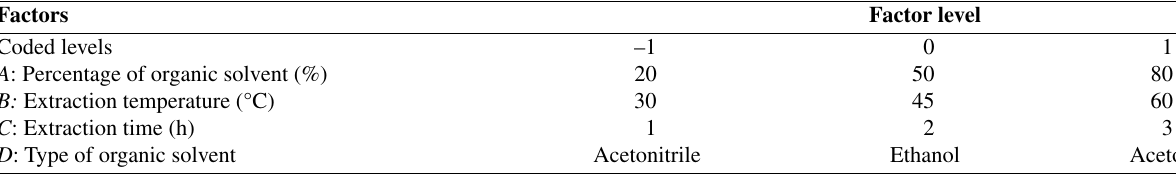
Table 1. Independent factors and their levels used in the response surface design